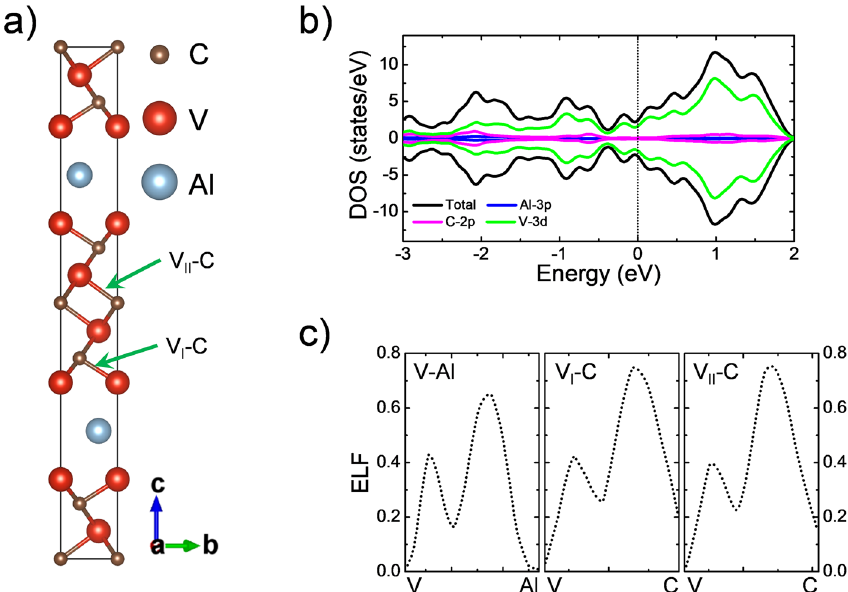
Figure 1. ( a ) atomistic model of the V 4 AlC 3 MAX compound, ( b ) Total and projected density of states, and ( c ) the line profiles of electron localization